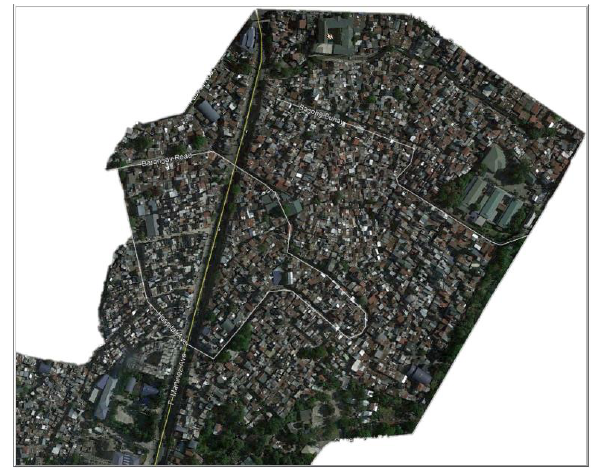
Figure 1 . Satellite image of Addition Hills retrieved from Google Earth.